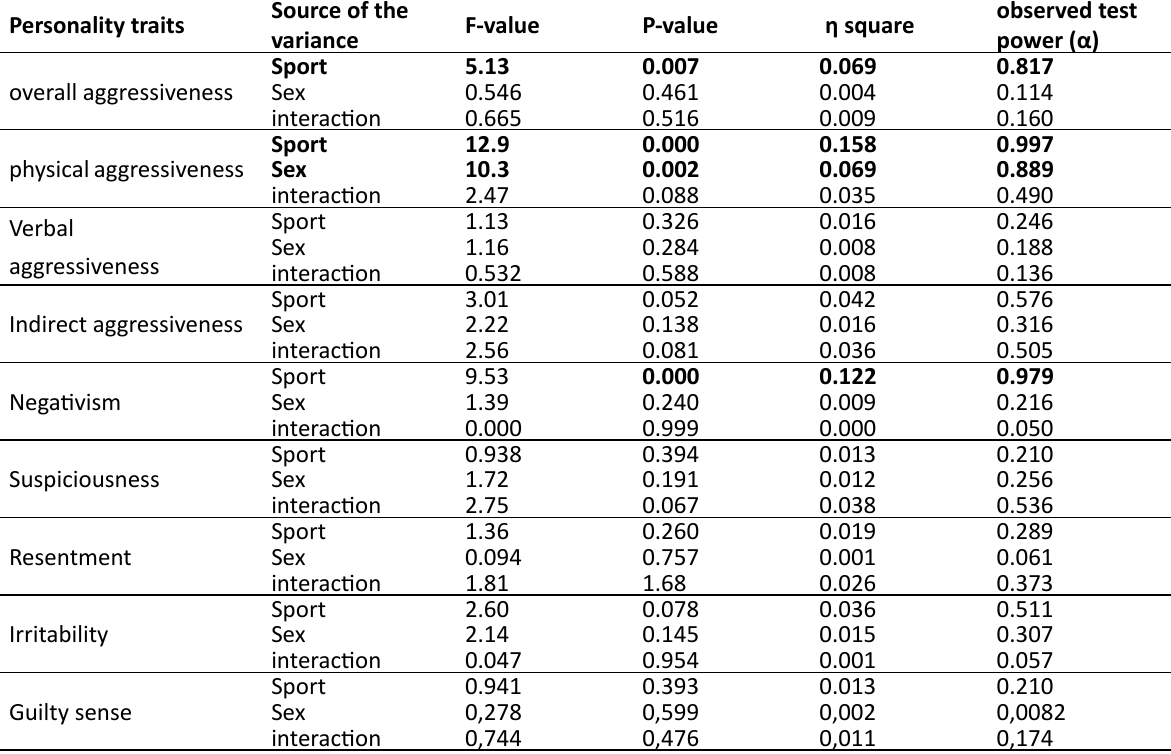
Table 4. Detailed results of variance analysis for components of